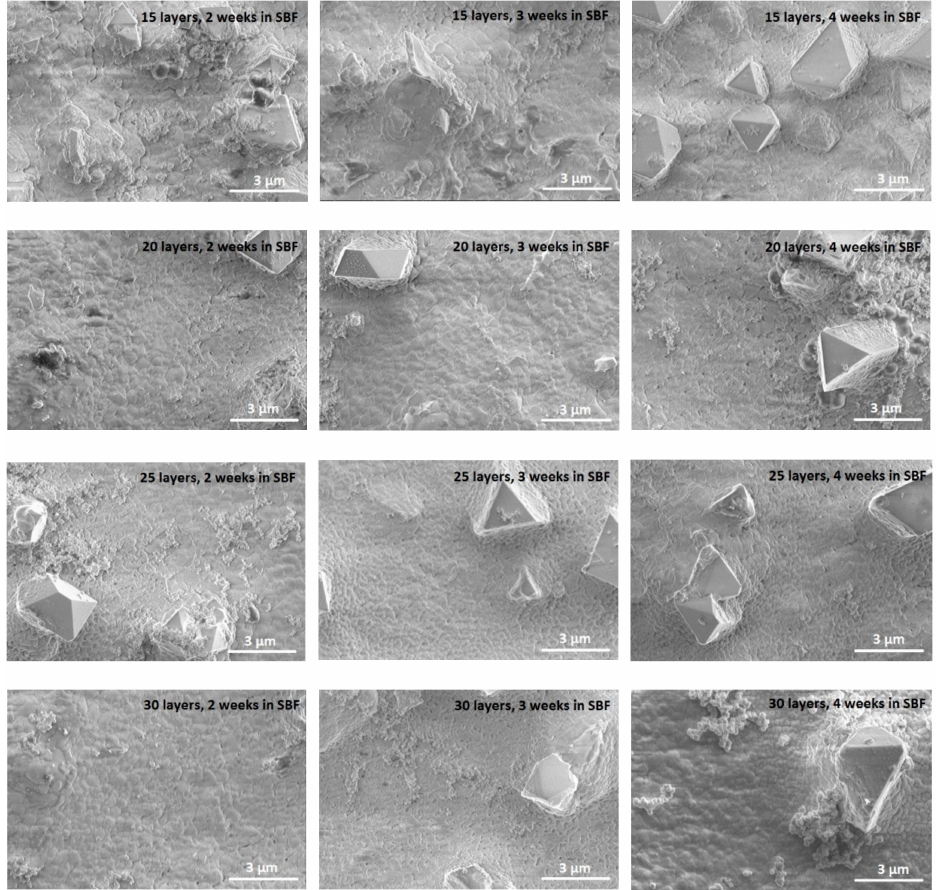
Figure 14. SEM micrographs of CHA samples coated with 15, 20, 25, and 30 layers after immersion in SBF for 2, 3, and 4